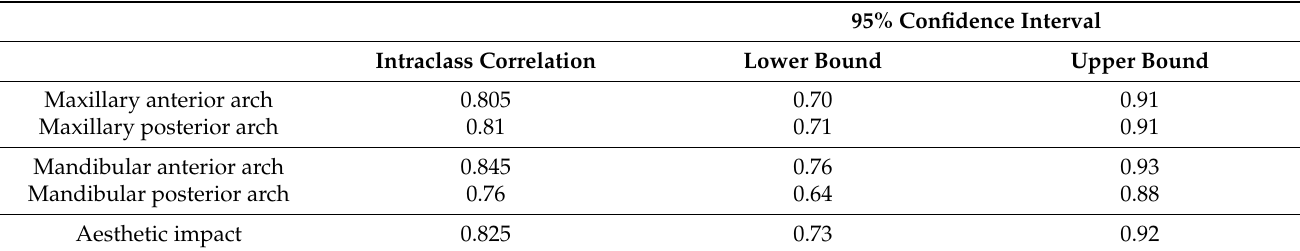
Table 2. Interexaminer correlation coefficient from the main